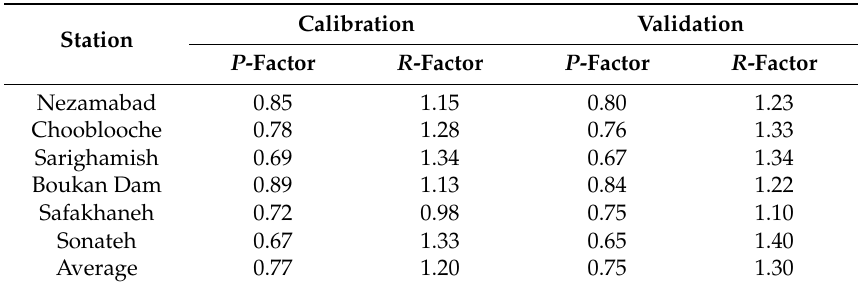
Table 5. SWATCUP-SUFI2 P- and R- factor uncertainty indices for calibration and validation for the different streamflow gauge stations.